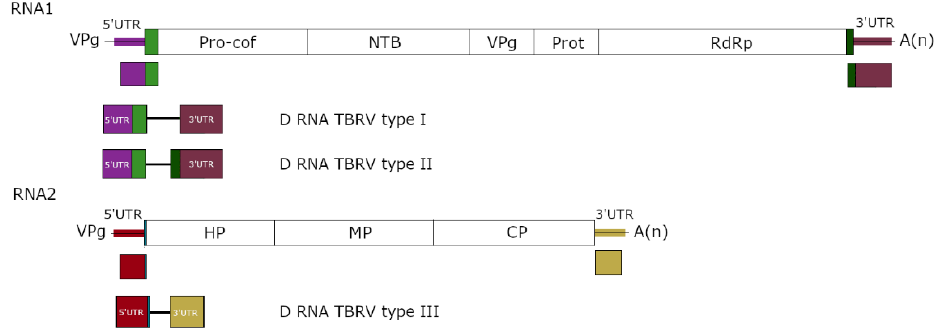
Figure 2. Structure of different TBRV D RNA types. The coloured fragments in the D RNAs correspond to the regions in HV. The black lines represent the recombination breakpoints.